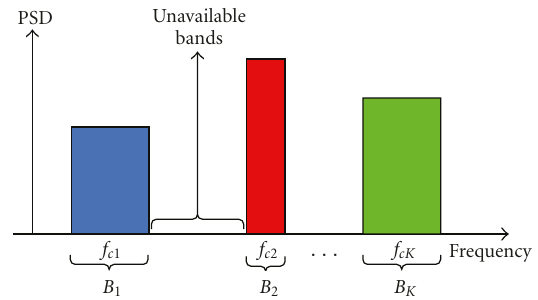
Figure 1: Illustration of dispersed spectrum utilization in cognitive radio